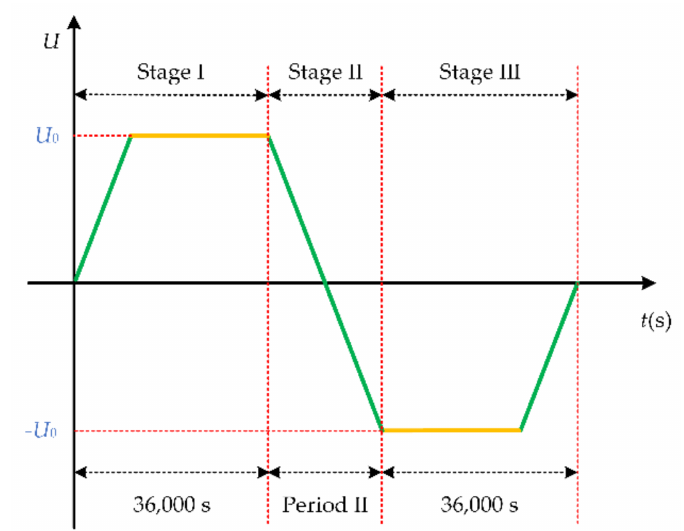
Figure 3. DC external voltage application